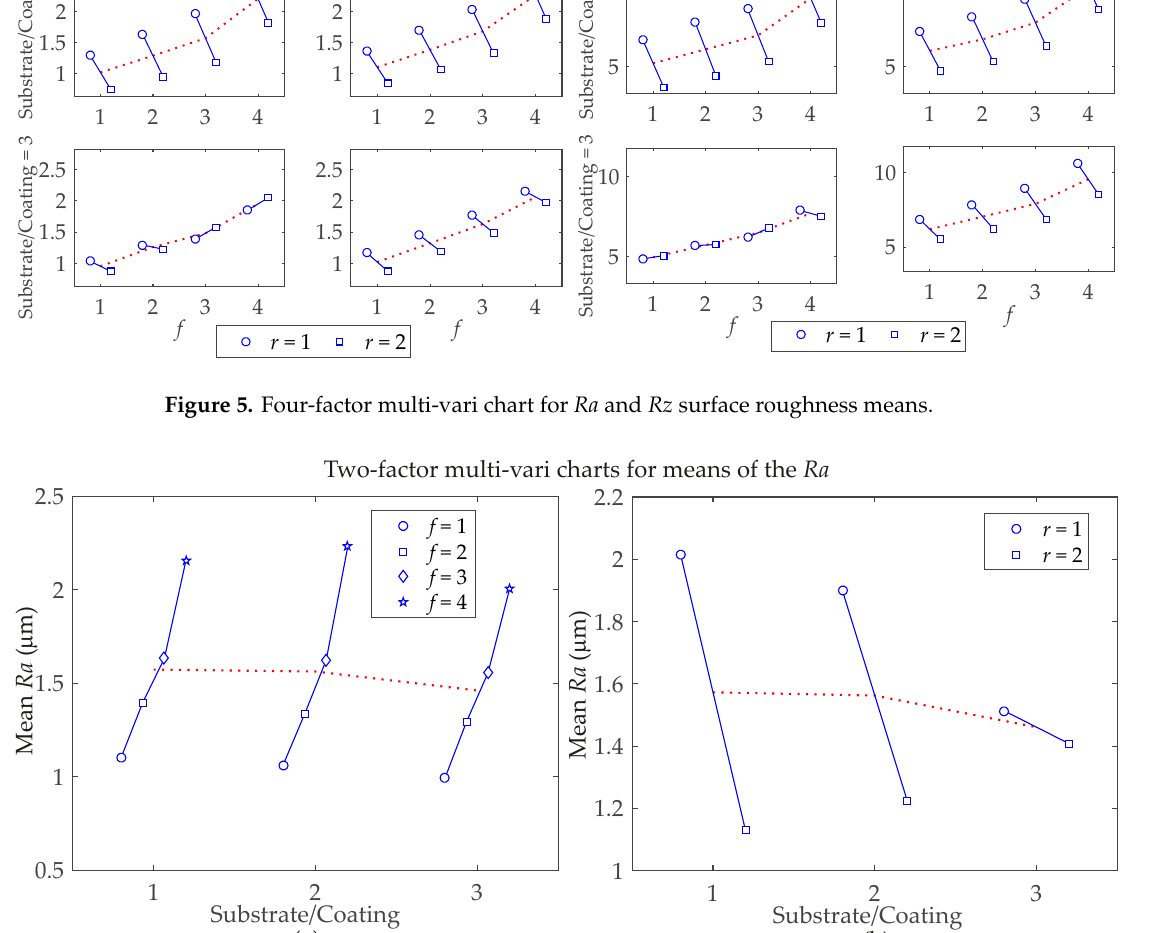
Figure 7. Two-factor multi-vari charts for Rz surface roughness parameter means, considering interactions between: ( a ) Substrate/Coating with nose radius;( b ) Substrate/Coating with feed rate; ( c ) Substrate/Coating with depth of cut; ( d ) Substrate/Coating with cutting speed.